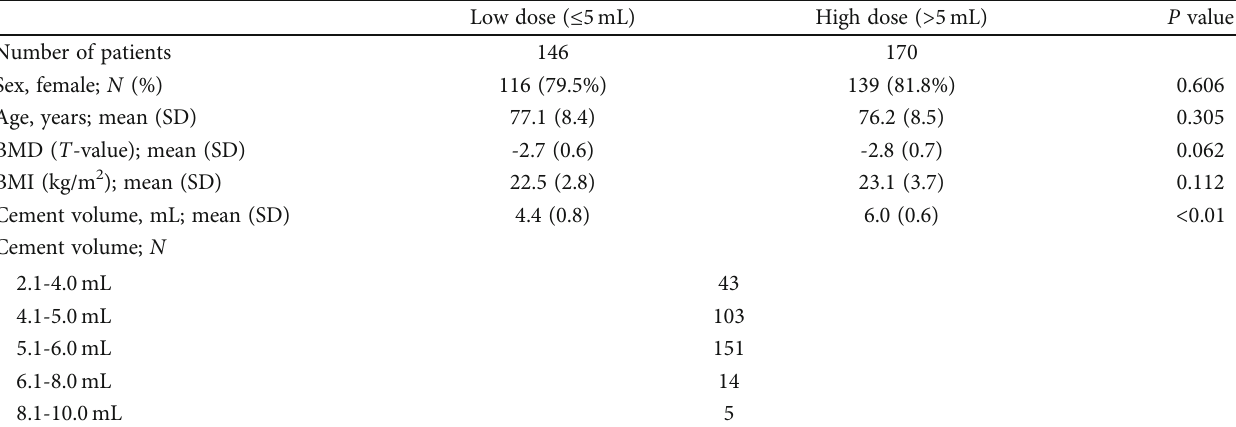
Table 1: Baseline characteristics of the 316 patients with thoracolumbar OVCFs treated with di ff erent volumes of cement.